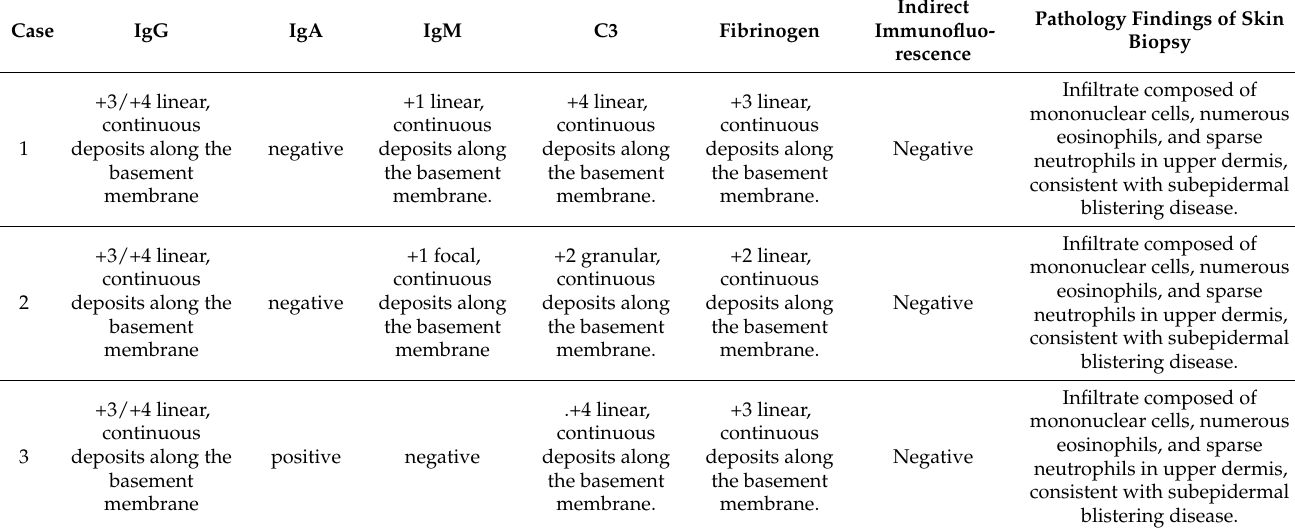
Table 1. Summary of